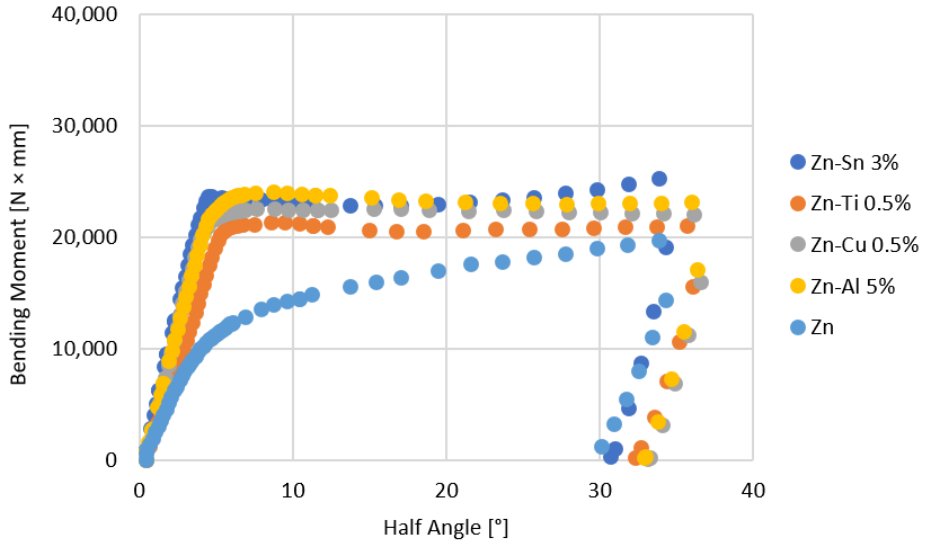
Figure 7. Bending tests results for all specimens investigated for 15 s dipping time.